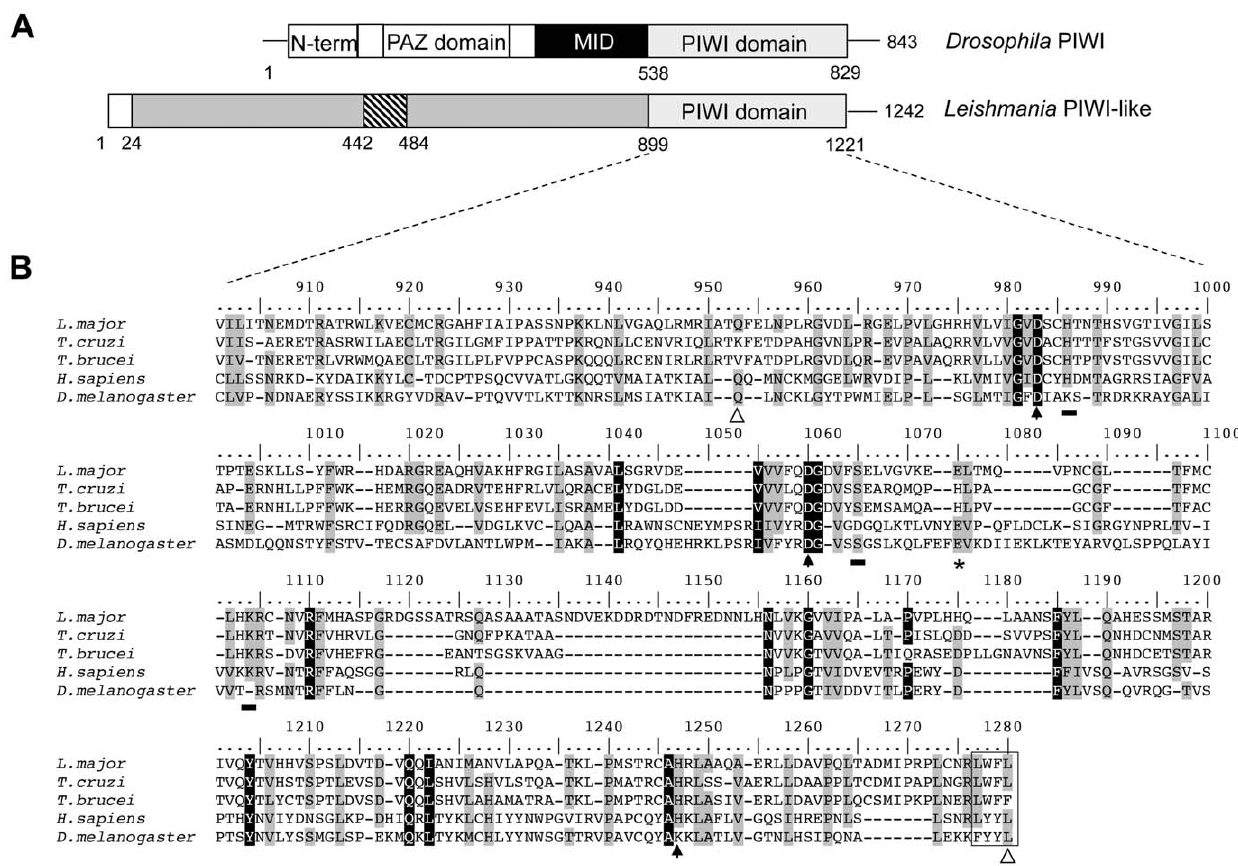
Figure 1. The Leishmania PIWI-like protein homolog forms a distinct group of the Argonaute/PIWI subfamily. (A) Structural domains (N- term, PAZ, MID, PIWI) of the Argonaute/PIWI proteins in higher eukaryotes (e.g. Drosophila ) and in the unicellular parasitic protozoan Leishmania . In Leishmania only the C-terminal PIWI domain is found (residues 899–1221). The Leishmania PIWI-like homolog contains a small domain (residues 450– 492, hatched box) with homology to the mitochondrial cytochrome C oxidase subunit VIIIb. A signal peptide of 24 residues has been predicted at the N-terminus of the Leishmania PIWI-like homolog. (B) Multiple sequence alignment of PIWI domains from L. major , the related trypanosomatids Trypanosoma cruzi and T. brucei , H. sapiens HIWI and the Drosophila melanogaster PIWI. The alignment was conducted using the Bioedit program [74]. Residues that are universally invariable among all eukaryotic Argonaute (AGO) proteins are shaded black. Residues that are highly conserved in all AGO proteins are shaded grey. Divalent anion-binding residues (Gln and Leu; residues 952 and 1242) are indicated by open arrows and the catalytic AGO triad (DDH; residues 981, 1048 and 1210) are indicated by black arrows. In the Drosophila PIWI homolog, the histidine (H) residue of DDH is not conserved but instead a lysine residue is present (DDK). The glutamate at position 1061, part of the RNase H-like DDE motif, is indicated by an asterisk. Residues putatively involved in RNA binding are underlined by a black rectangle. The C-terminus hydrophobic residues are boxed.